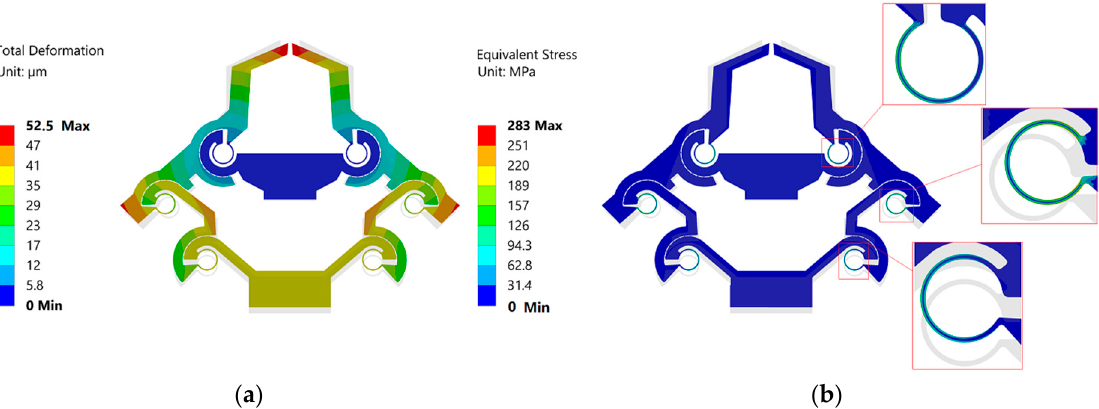
Figure 7. ( a ) Total displacement; ( b ) stress field when 39.16 µ m input displacement is applied at the shuttle of the